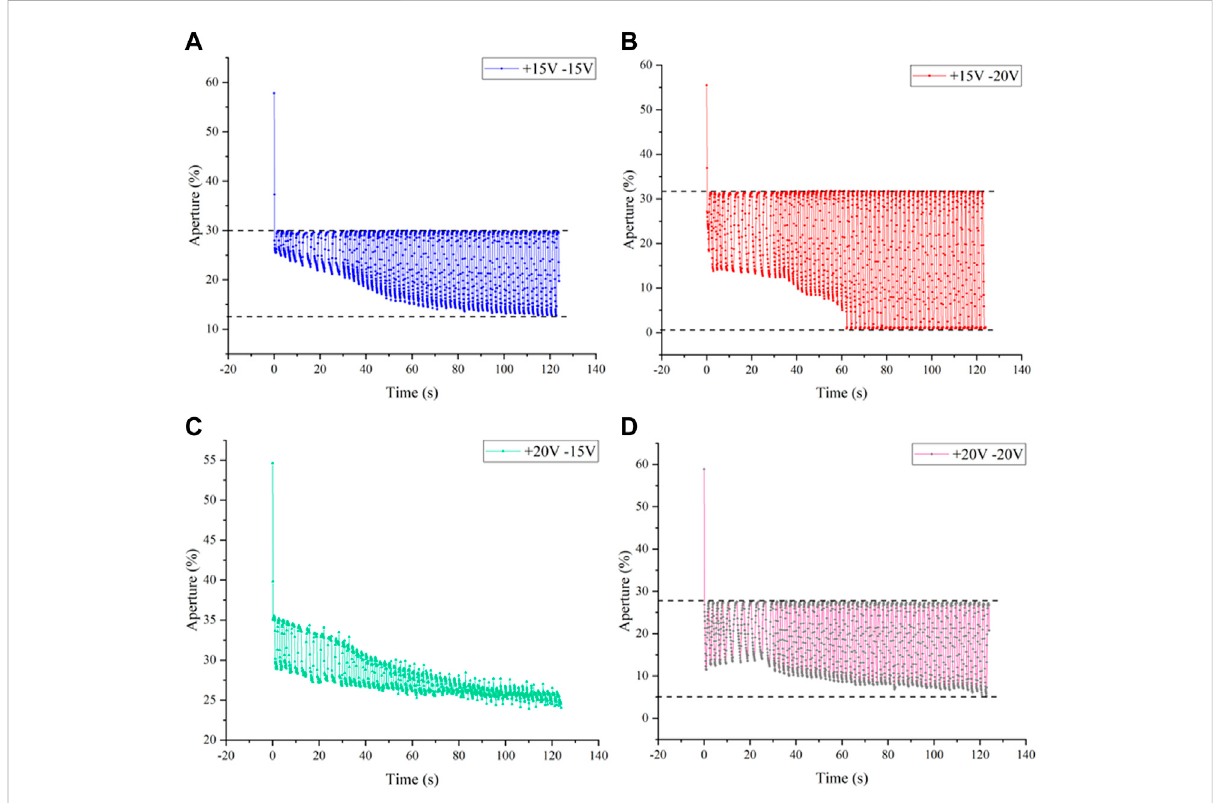
FIGURE 9 Aperture ratio with AC driving. (A) Aperture ratio with AC driving composed of +15 V and -15 V. (B) Aperture ratio of AC driving composed with +15 V and -20 V. (C) Aperture ratio with AC driving composed of +20 V and -15 V. (D) Aperture ratio with AC driving composed of +20 V and -20 V.